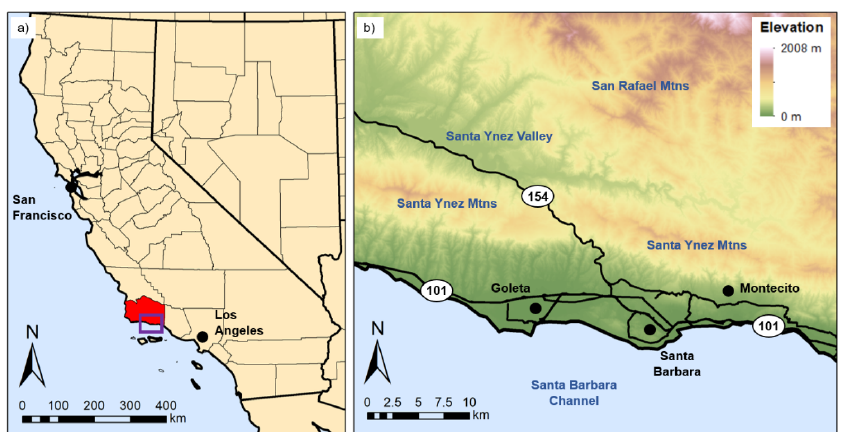
Figure A1. ( a ) State and county borders, with Santa Barbara County colored red. ( b ) Topography in southern Santa Barbara County (see purple box in ( a ) for subset). Cities are in black text and geographic features are in blue text. The thick lines indicate major roads, and highways are labeled.